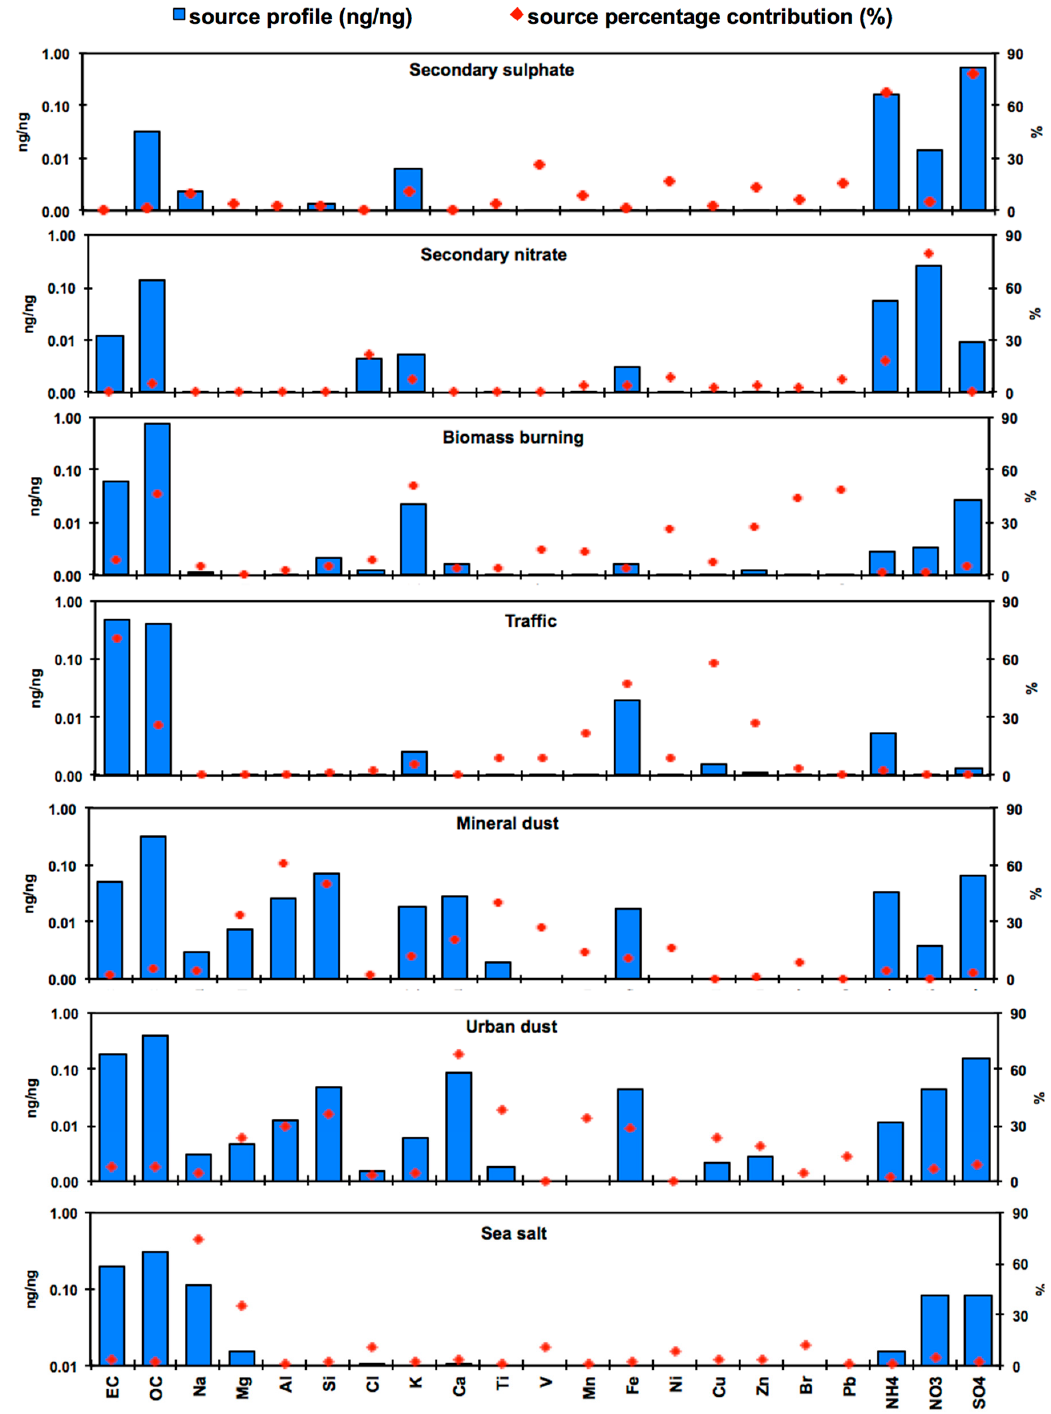
Figure 5. Source profiles obtained by PMF analysis of the TS–UB data set: normalised contributions of each specie to the chemical profile of each source (ng/ng, blue bars) and average percentage contribution of each source to the concentration of each element (%, red points).